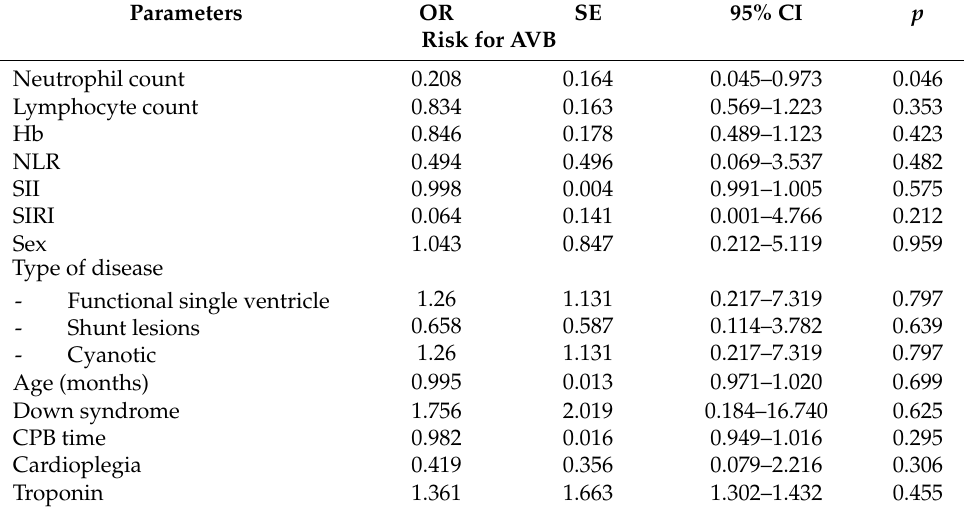
Table 2. The logistic regression analysis of preoperative factors for postoperative A-V